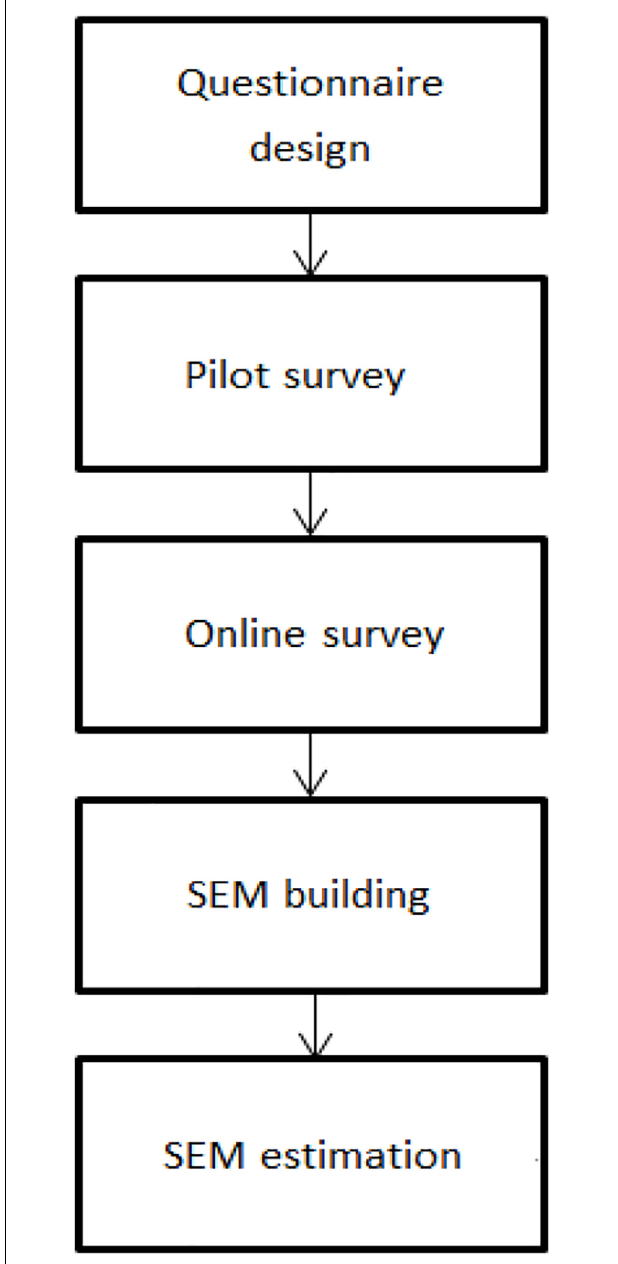
FIGURE 2 | The experimental design.